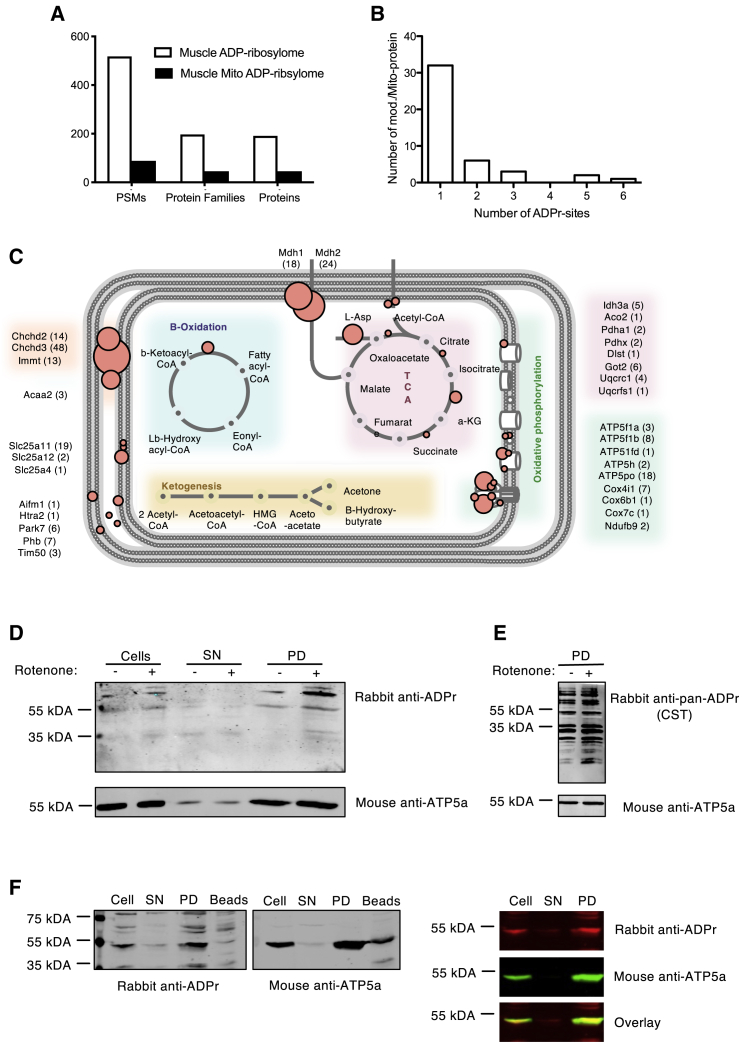
Identification of Mitochondrial ADP-Ribosylated Proteins by Mass Spectrometry(A) Number of peptide spectral matches (PSMs), protein families, and proteins identified to be ADP-ribosylated in mouse muscle tissue (white, total proteins; black, mitochondrial proteins).(B) Frequency of ADP-ribosylation regions identified on mitochondria-localized proteins.(C) Schematic overview of the distribution of protein ADP-ribosylation detected in mitochondria from murine muscle. ADP-ribosylation is indicated using a red circle. Each circle represents an ADP-ribsosylated protein or subunit; the size of each circle depicts the number of times the modified peptide/protein was identified by MS, and spectral counts for each protein are indicated in parentheses.(D) Anti-ADPr antibody stained western blot of whole-cell and mitochondrial lysates isolated from untreated and rotenone-treated U2OS cells stably transfected with HA-tagged OMP25.(E) WB on mitochondrial lysates from untreated and H2O2-treated cells stained with a commercial pan-ADPr antibody.(F) WB stained for ADP-ribosylation and ATP5a on mitochondrial lysates isolated from U2OS cells stably transfected with HA-tagged OMP25 (SN, supernatant; PD, pull-down).